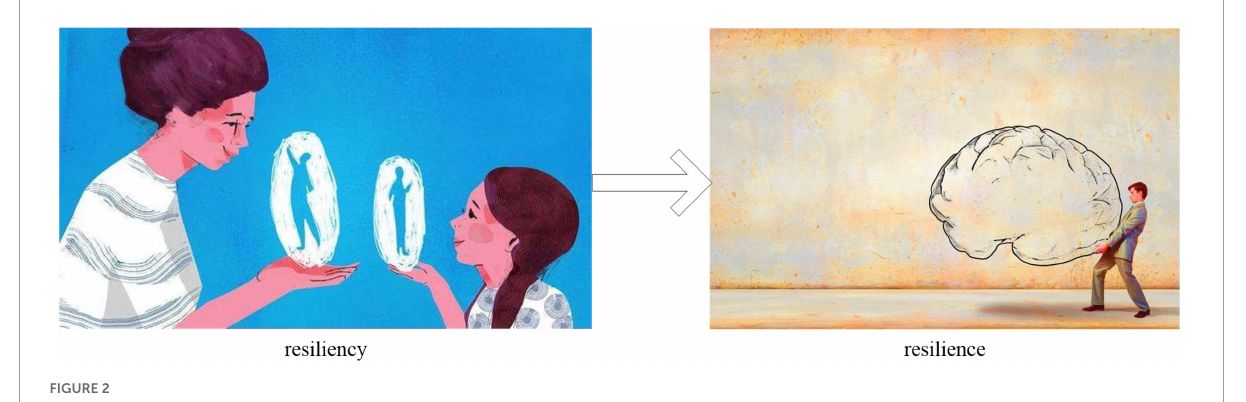
FIGURE2 Mental toughness.